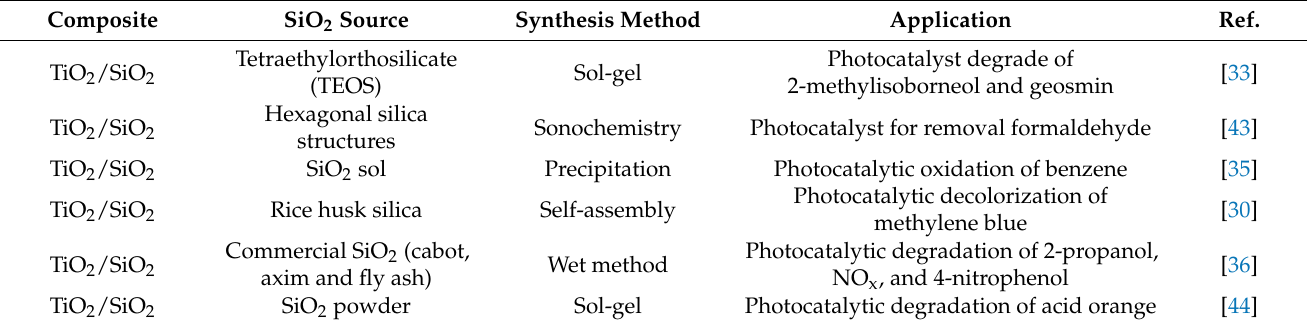
Table 8. Comparison of various TiO 2 /SiO 2 composites with SiO 2 sources and their applications. Composite